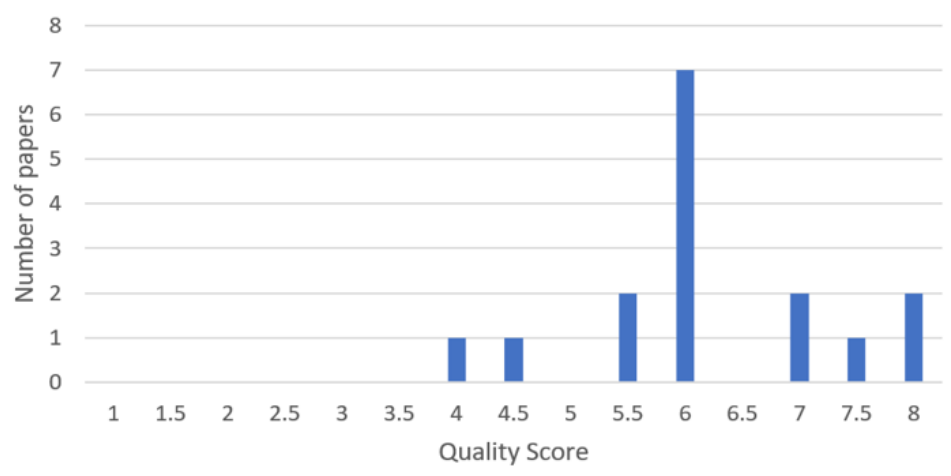
Figure 3. Paper distribution based on quality score.